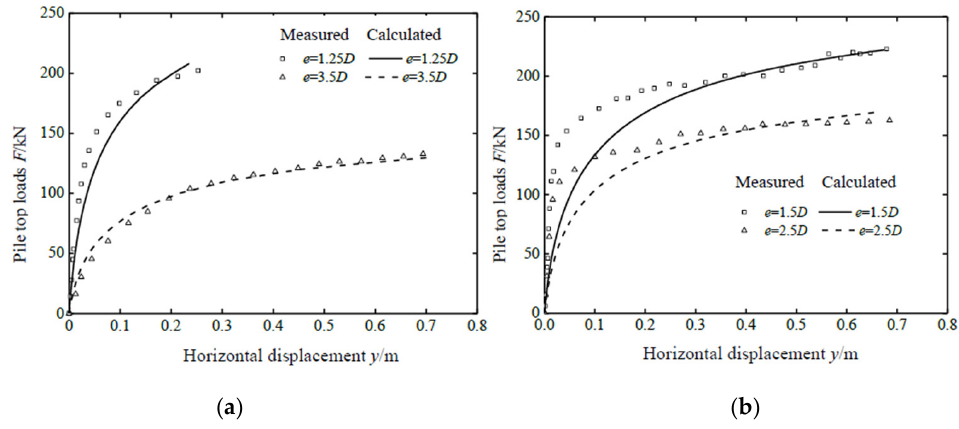
Figure 10. Comparison of load–displacement curves. ( a ) s u = 1 + 1.1 z , ( b ) s u = 1 + 1.3 z .